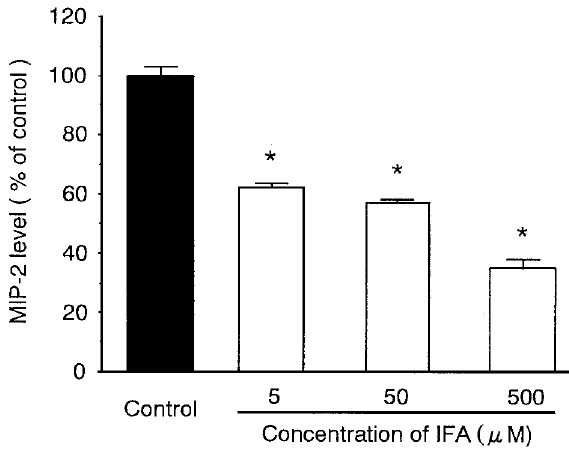
FIG. 2. Inhibitory effect of IFA on MIP-2 production in RAW264.7 cells in response to RSV infection. RAW264.7 cells were infected with RSV by the same manner as described in the legend for Fig. 1. After absorption for 1h, the cells were cultured in the presence of IFA at the indicated concentra- tions (open bar). The MIP-2 levels in 20-h conditioned media were determined and expressed as MIP-2 level by percent of control cultured in the absence of drugs (closed bar). Asterisks indicate a significant difference from control with a P value of <0.05. Data are shown as the mean (thick bar)± SD (thin bar) of three